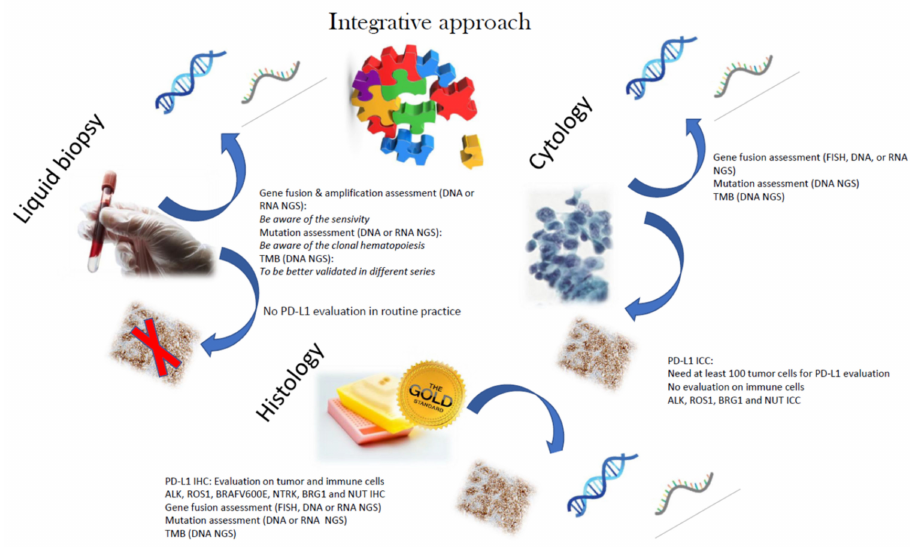
Figure 3. The complementary role of tissue biopsies, cytological specimens, and liquid biopsies for the characterization of presently available and future biomarkers at diagnosis of non-squamous non-small cell lung